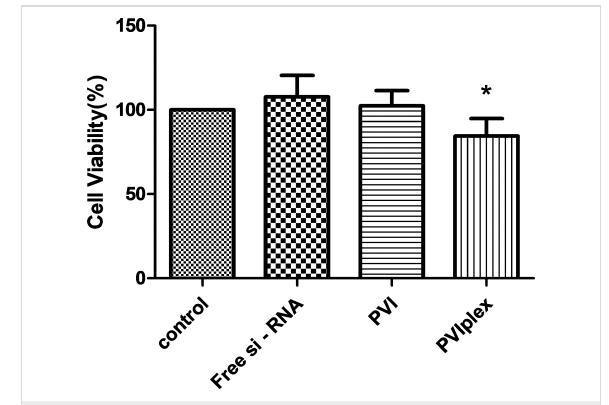
Figure 7: Cell viability of A549 cancer cells after treatment with carrier systems (blank carrier and the polyplex obtained after complexation with anti-VEGF siRNA). The A549 cells displayed a lower viability after 48 h of treatment ( p < 0.05 vs control, n =